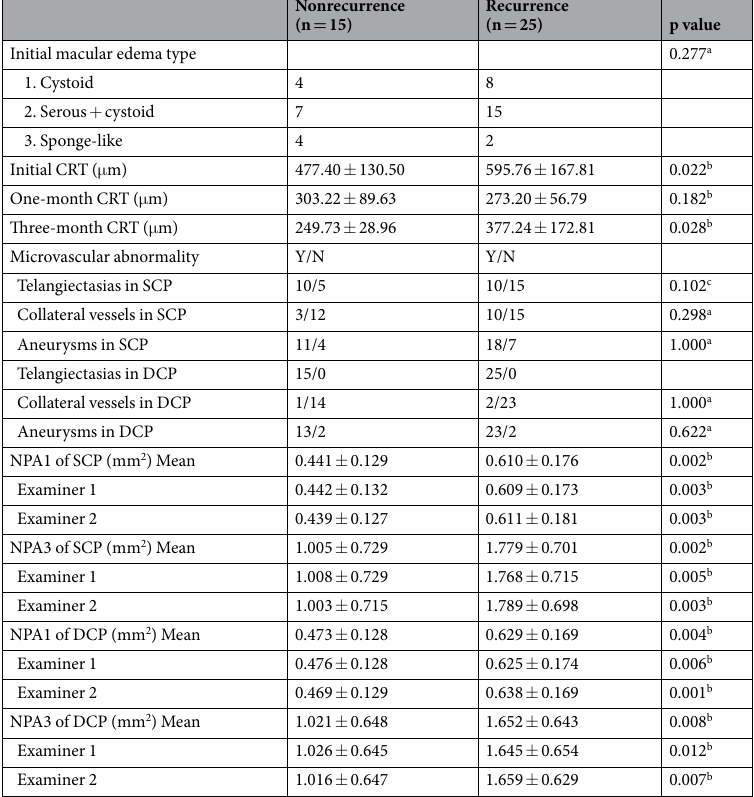
Table 3. Optical coherence tomography and optical coherence tomography angiography findings of the study patients. CRT = central retinal thickness; DCP = deep capillary plexus; NPA1 = nonperfusion area in the 1-mm zone; NPA3 = nonperfusion area in the 1- to 3-mm zone; SCP = superficial capillary plexus. a Fisher’s exact test. b Mann–Whitney U test. c Pearson chi-square